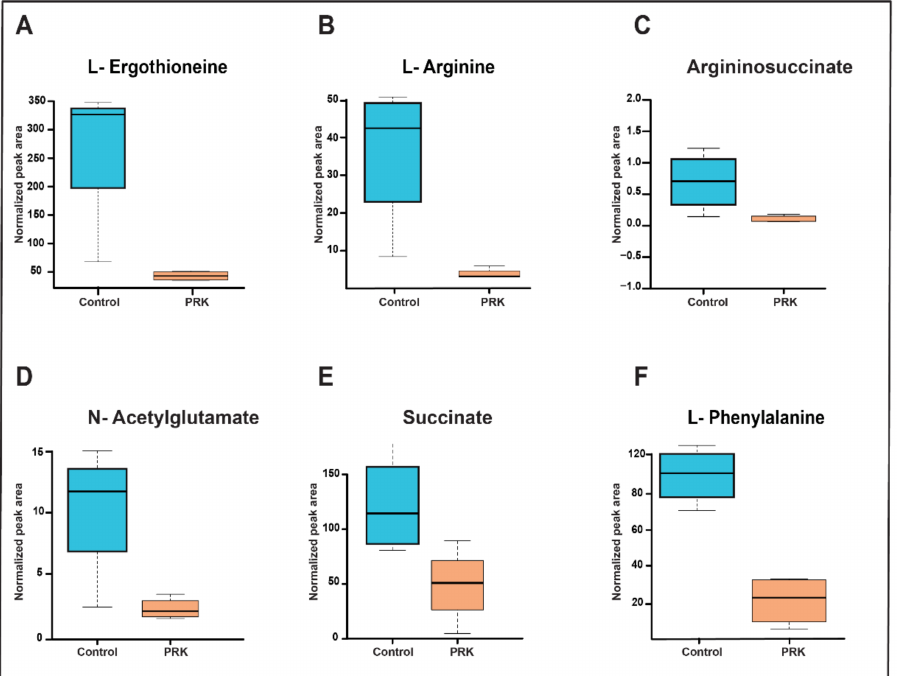
Figure 6. Box plots of validated metabolites showing differential expression of metabolites in control and PRK-treated Mtb H37Rv groups. ( A ) L-Ergothioneine, ( B ) L-Arginine ( C ) Argininosuccinate,